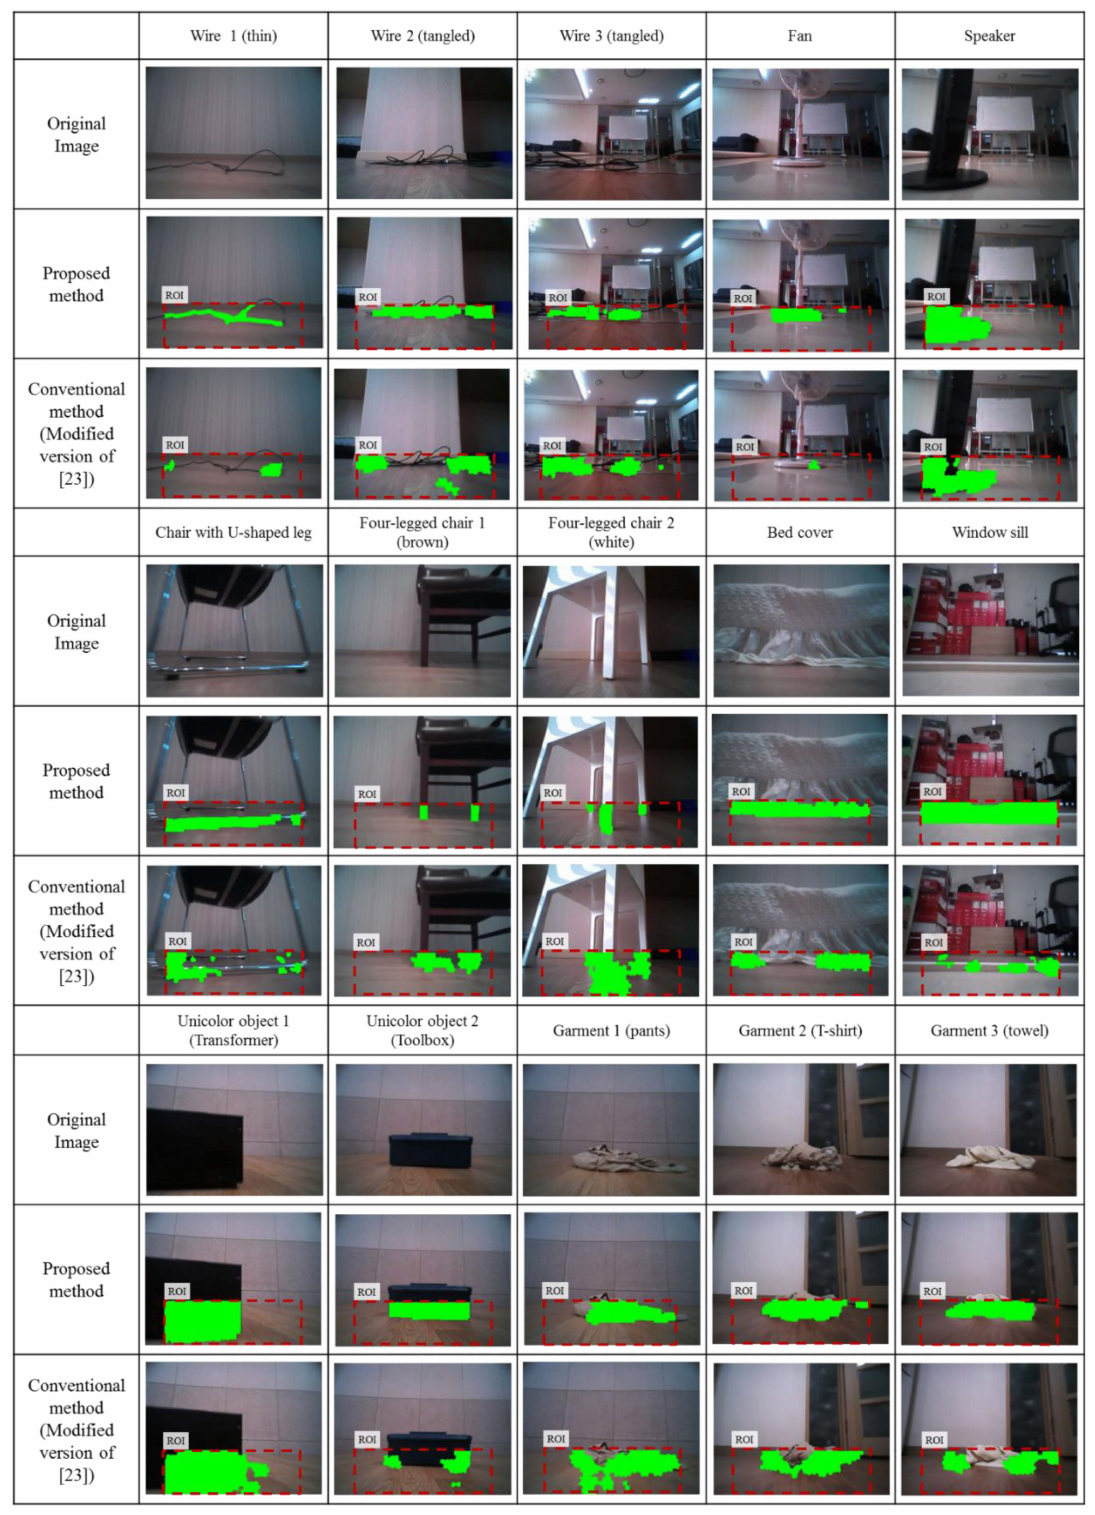
Figure 13. Obstacle labeling results from the proposed and conventional